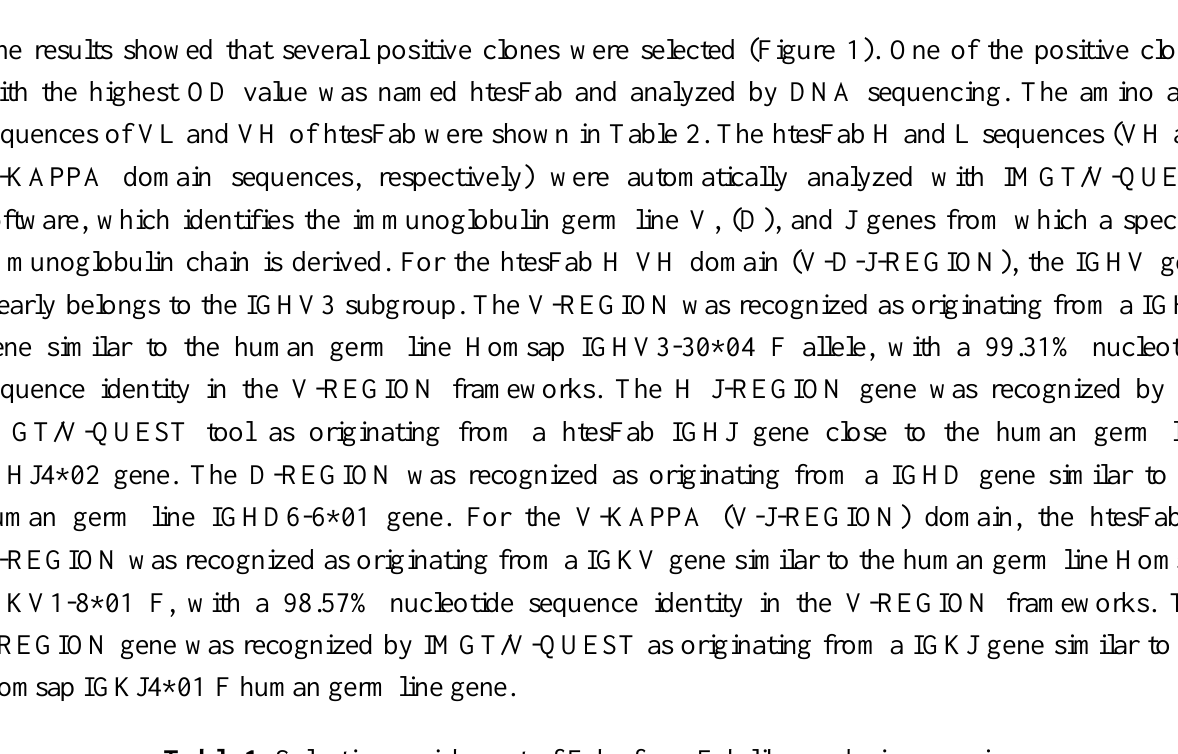
Table 1. Selective enrichment of Fabs from Fab library during panning.